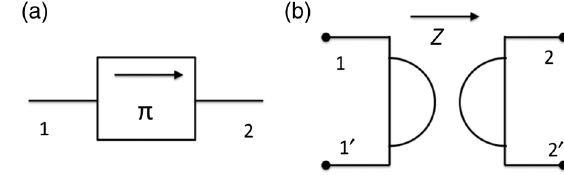
FIG. 3. The gyrator, a two-port nonreciprocal device. (a) The “ quasioptical ” conventional symbol [1], emphasizing that the gyrator imparts a phase inversion to signals propagating in one direction only. (b) The lumped-element four-terminal symbol of the gyrator. According to Tellegen ’ s definition [18], the port currents and voltages satisfy the equations V 2 ¼ ZI 1 , V 1 ¼ − ZI 2 . Z is the gyration resistance.